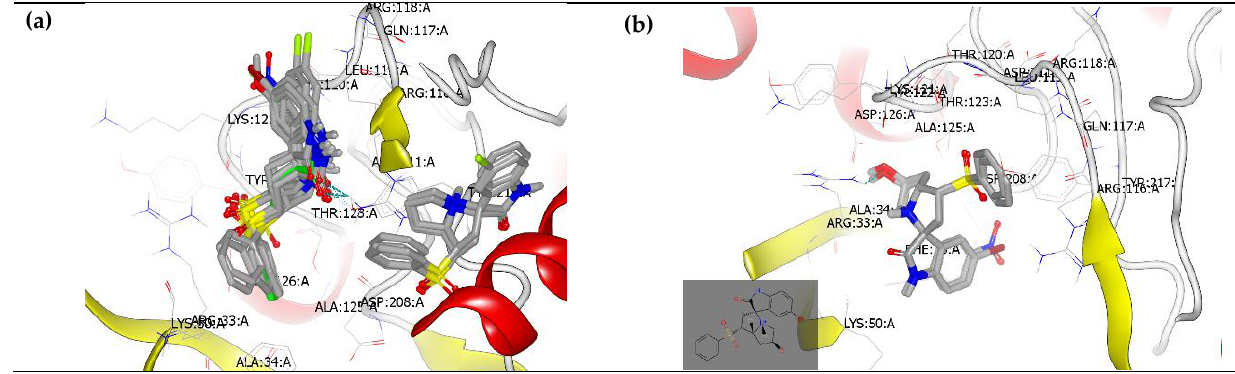
Figure 3. Visual representation for compounds docked against (PDBID: 6m71) visualized by vid application ( a ) shape alignment for synthesized compounds 4i, 4n, 4b, 4e, 4m, 4f, and 4j (left domain of receptor). Compounds 4a, 4g and 4k (right domain of receptor); ( b ) Compounds 4c , and 4d have the same binding mode and pose with formation of HB with Arg: 33A.